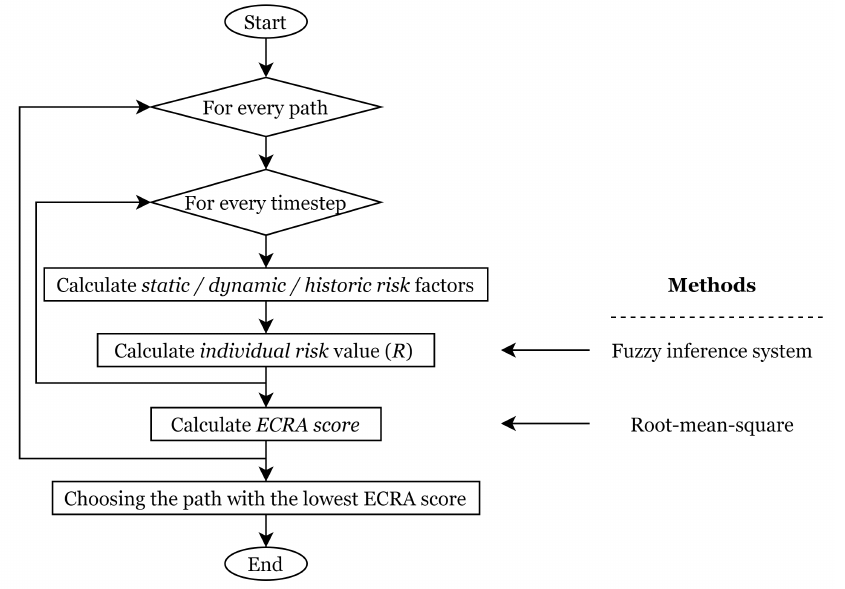
Figure 1. Flowchart of the extended collision risk assessment (ECRA) calculation for each path and corresponding methods